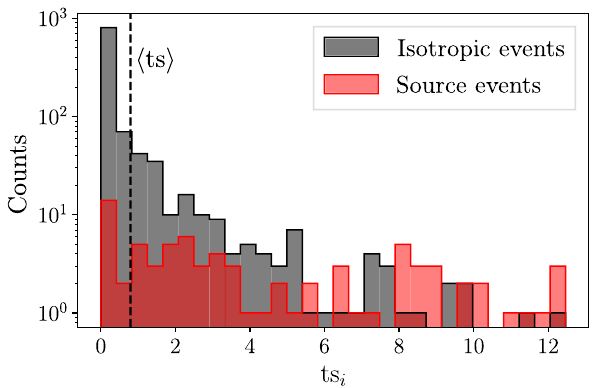
Fig. 10 Distribution of individual test statistics ts i as obtained in the benchmark 1 simulation (cf. upper right panel of Fig. 9). The red (gray) histogram shows the contribution of the 80 source (isotropically dis- tributed) events. The dashed vertical black line denotes the average test statistic (cid:10) ts (cid:11) of all events in the